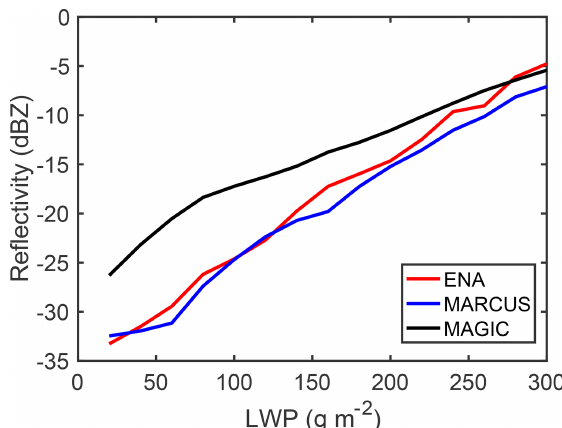
Figure 8. Mean KAZR reflectivity of the hydrometeor signal as a function of LWP in three campaigns: ENA (red line), MARCUS (blue line) and MAGIC (black